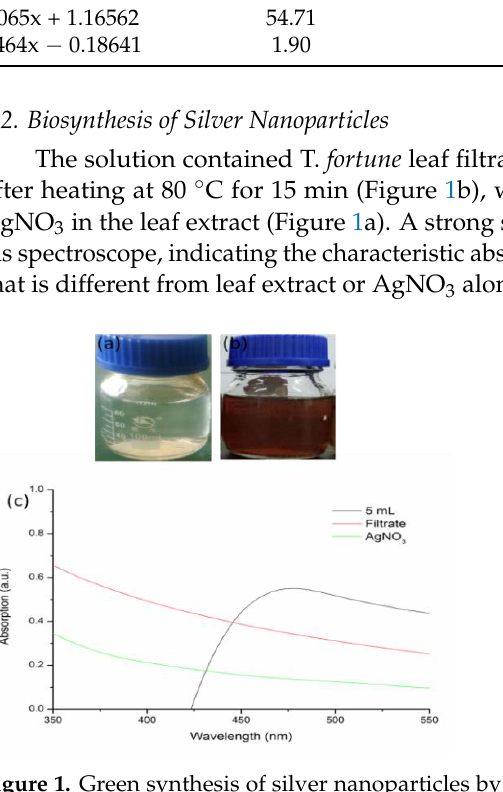
Figure 1. Green synthesis of silver nanoparticles by T. fortunei leaf extract. ( a ) leaf filtrate without AgNO 3 ; ( b ) leaf filtrate with AgNO 3 ; ( c ) UV-vis absorption spectrum. AgNO 3 ; ( b ) leaf filtrate with AgNO 3 ; ( c ) UV-vis absorption spectrum.